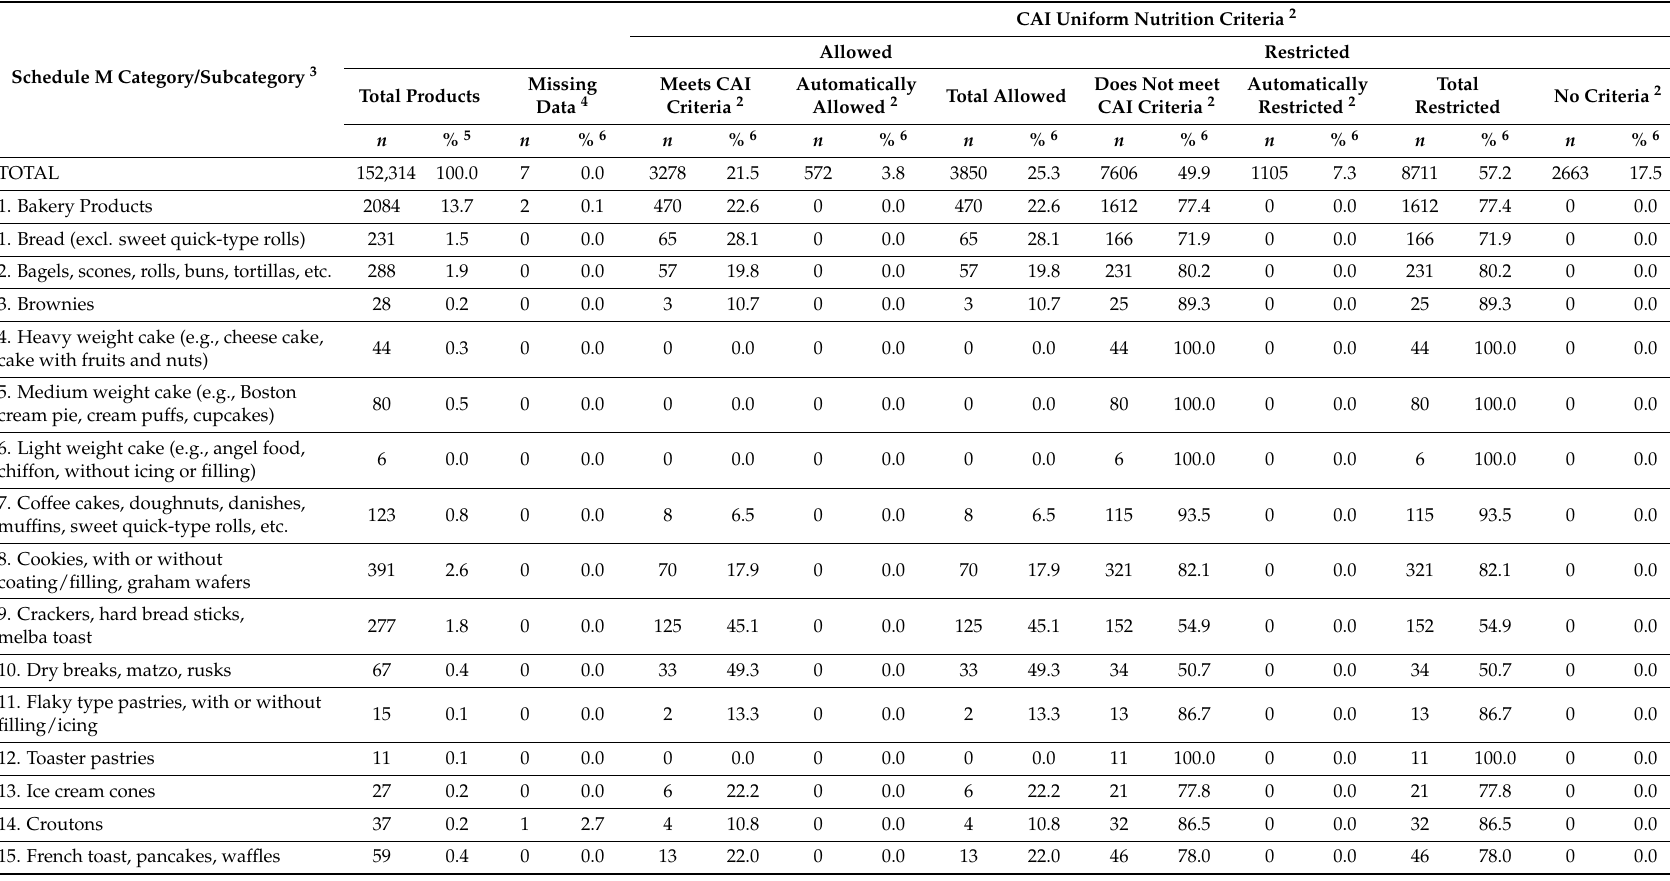
Table A1. Evaluation of Canadian packaged food and beverage products 1 according to the Canadian Children’s Food and Beverage Advertising Initiative’s (CAI) Uniform Nutrition Criteria 2 , presented by food subcategory 3